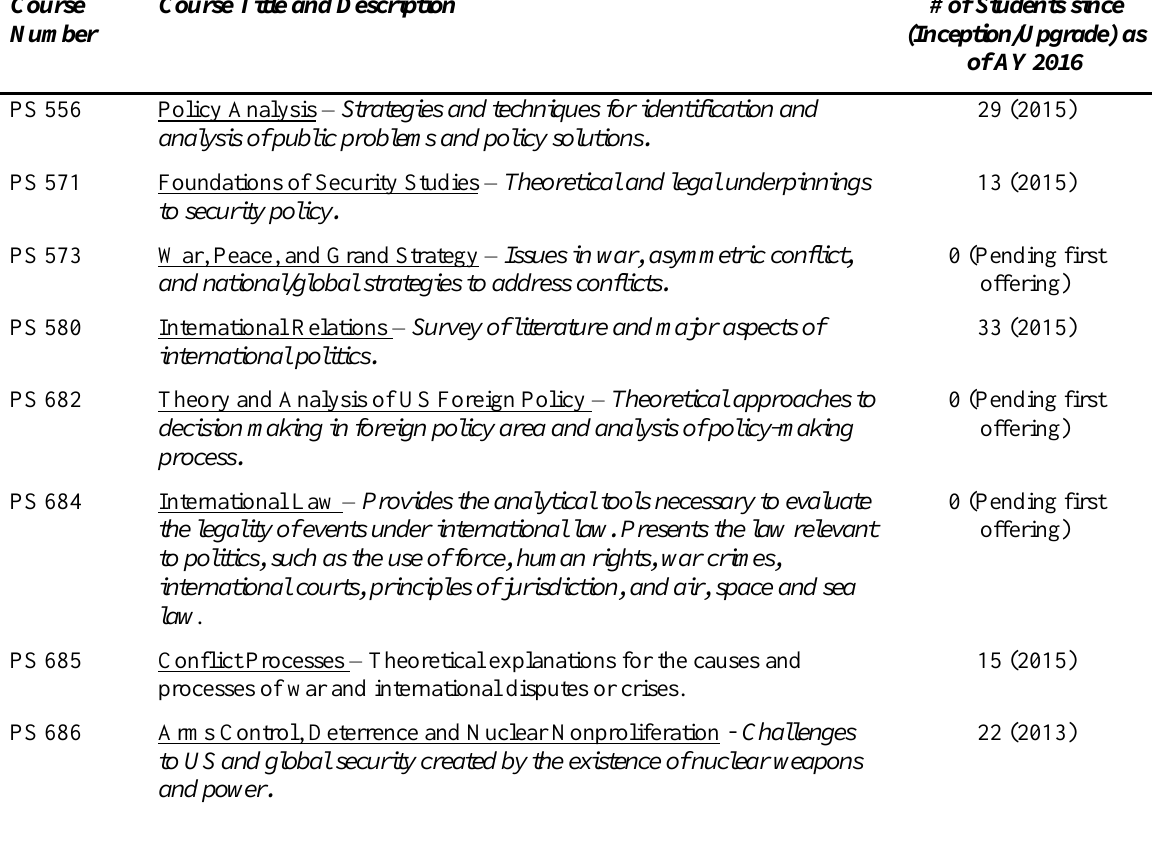
Table 2. Courses available to fulfill the global security track in the UT MPPA degree